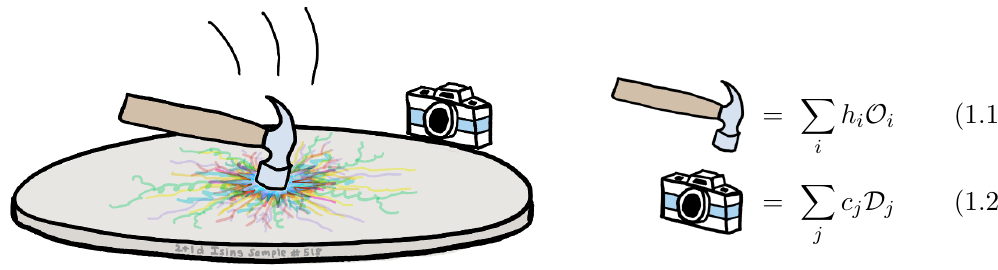
Figure 2. In an experiment involving a QFT Q , the probe (hammer) can be expanded in operators O i that are intrinsic to Q , schematically eq. (1.1). Similarly, a far-away measurement apparatus (camera) can be expanded in detectors D i that are intrinsic to Q , eq. (1.2). These twin expansions cleanly separate the details of the experiment (contained in the coefficients h i and c j ) from the dynamics of the theory (encoded in matrix elements hO i |D j |O k i ).